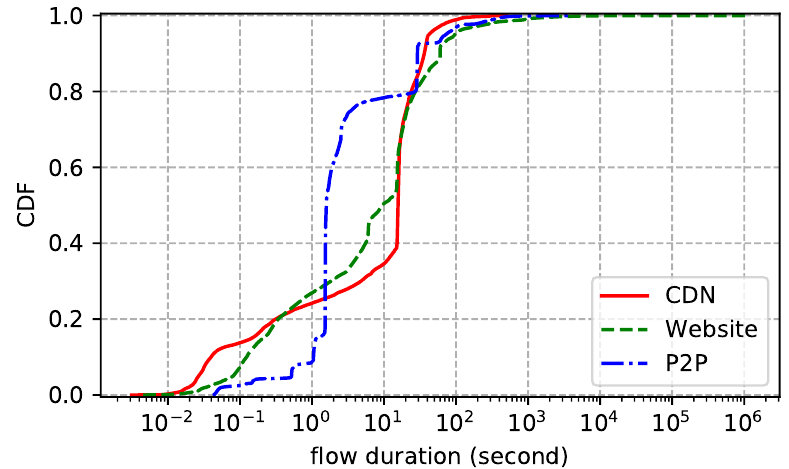
Figure 3. Flow duration distribution of each dataset.